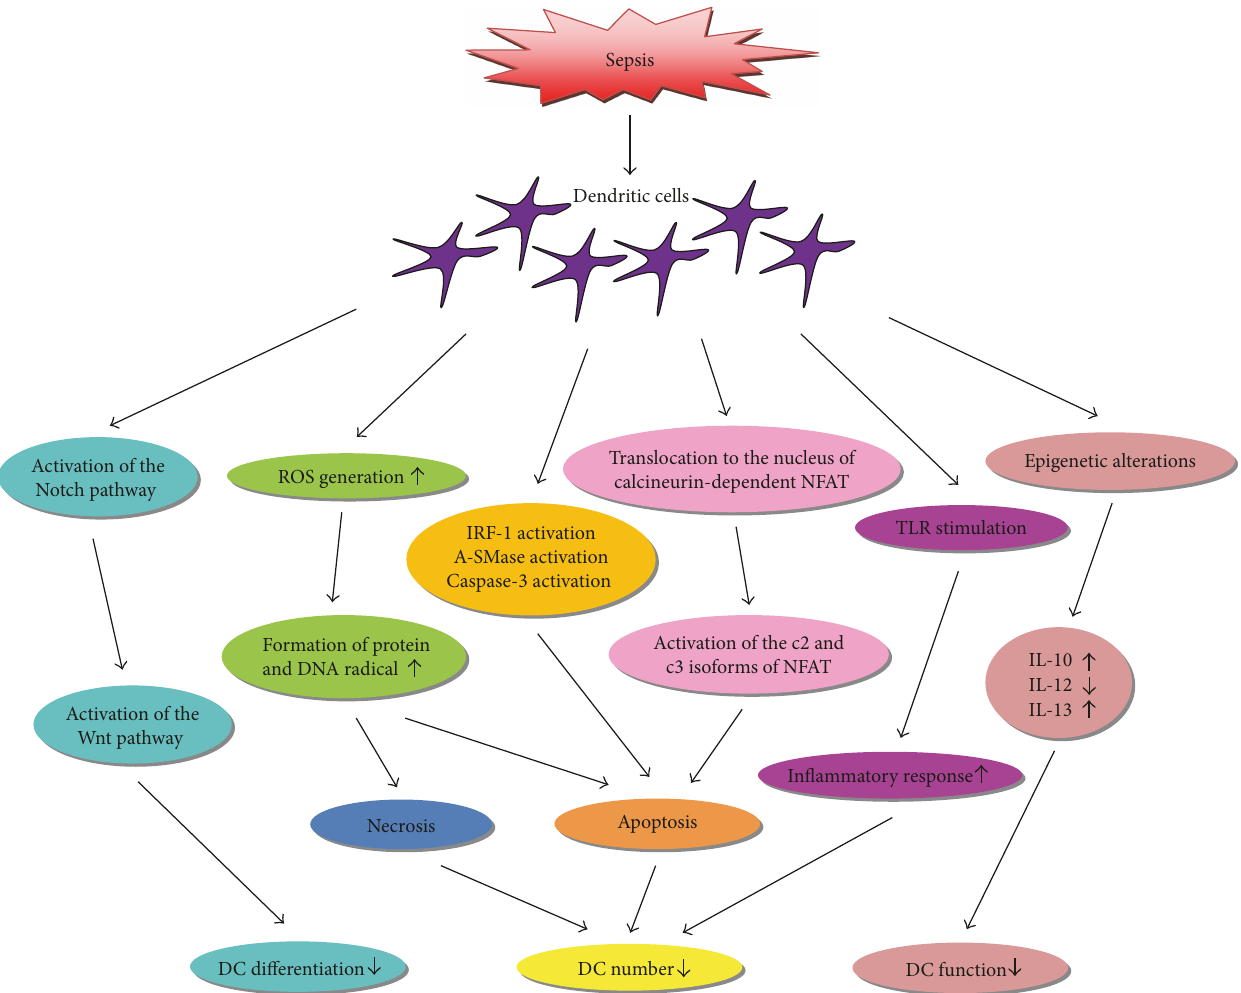
Figure 1: A schematic illustration of the alterations of dendritic cells (DCs) in sepsis. Induction of apoptosis, reactive oxygen species (ROS) generation, activation of Wnt signaling pathway, epigenetic regulation, and variation in toll-like receptor- (TLR-) dependent signaling are involved in the alterations of DCs in sepsis. NFAT: nuclear factor of activated T cells; IRF1: interferon regulatory factor 1; A-SMase: acid sphingomyelinase; DNA: deoxyribose nucleic acid; IL: